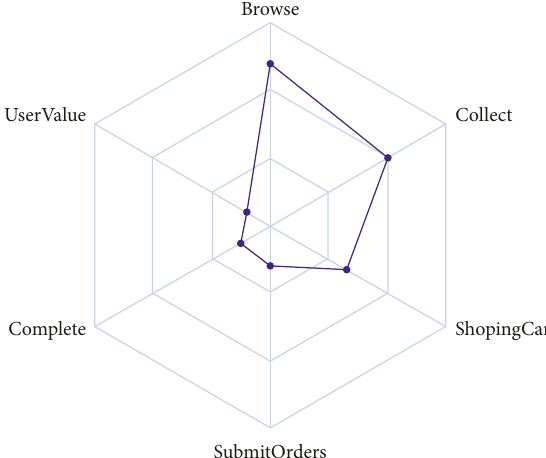
Figure 22: Individual user behavior